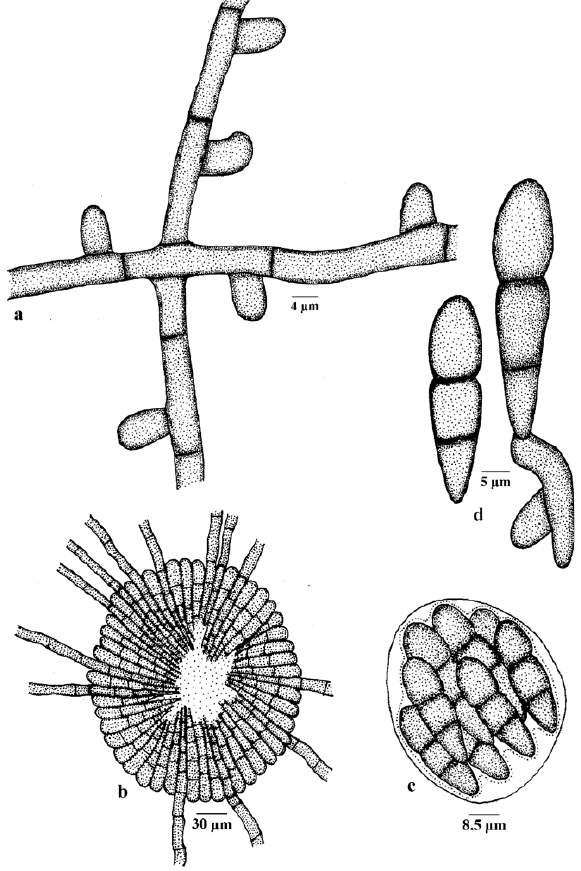
Figure 175. Meliolaster aporusae a.Appressoriate mycelium, b. Thyriothecium, c. Ascus, d.